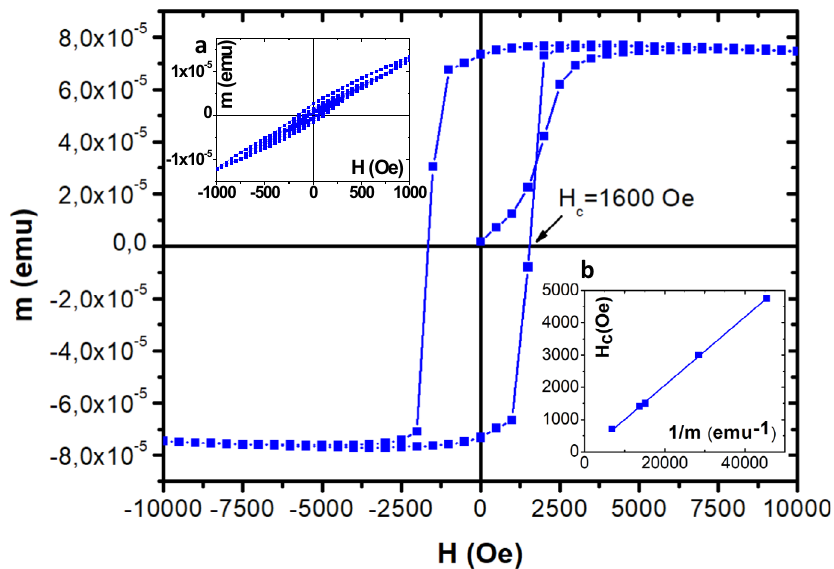
Fig. 2 Hysteresis loops. Inset a shows subsequent hysteresis loops, i.e., measurements of the magnetization m of a Mn 2 Au(001)(40 nm)/Py(4 nm) sample taken with increasing applied magnetic fi elds H up to 10 3 Oe (aligned parallel to the easy [110] direction of Mn 2 Au). The main panel shows the subsequent loop up to 10 4 Oe (also aligned parallel to [110]). Inset b shows the coercive fi eld H c vs. the inverse saturation magnetization (with linear fi t) obtained from Mn 2 Au(40 nm)/Py bilayers with the Py thickness varying from 2 to 10